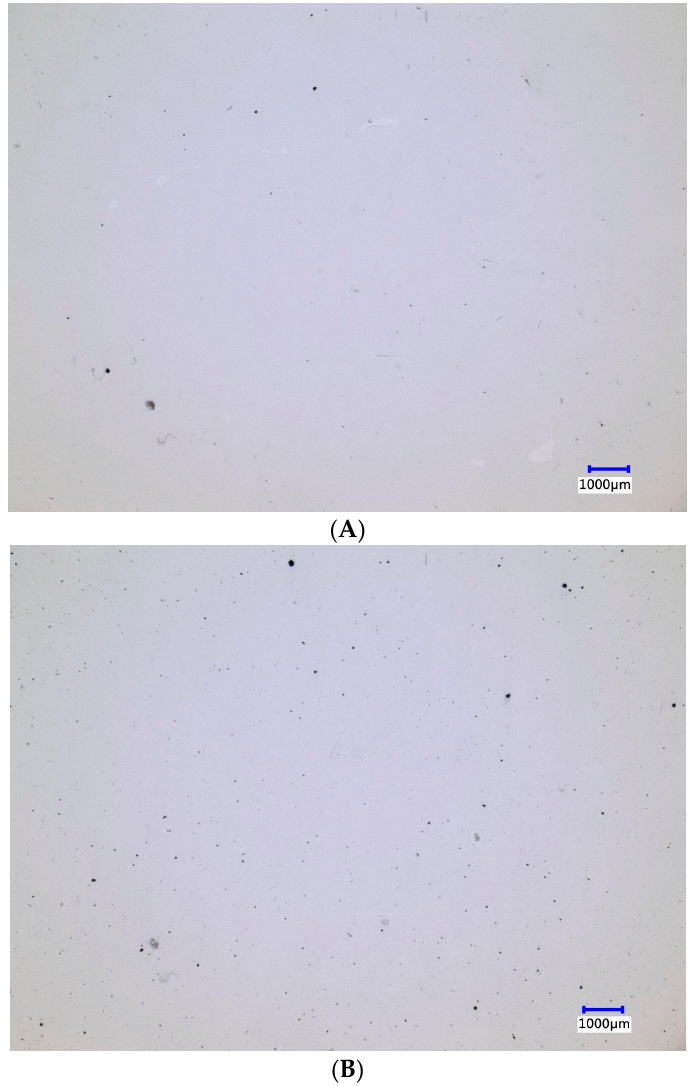
Figure 1. Optical micrographs for ABA films fabricated using masterbatch with MFI = 34 g/10 min. The masterbatches were fabricated using ultrasound-assist method V-U. ( A ) 0.1 wt % MWCNT; and ( B ) 1.0 wt % MWCNT in the A-layers.